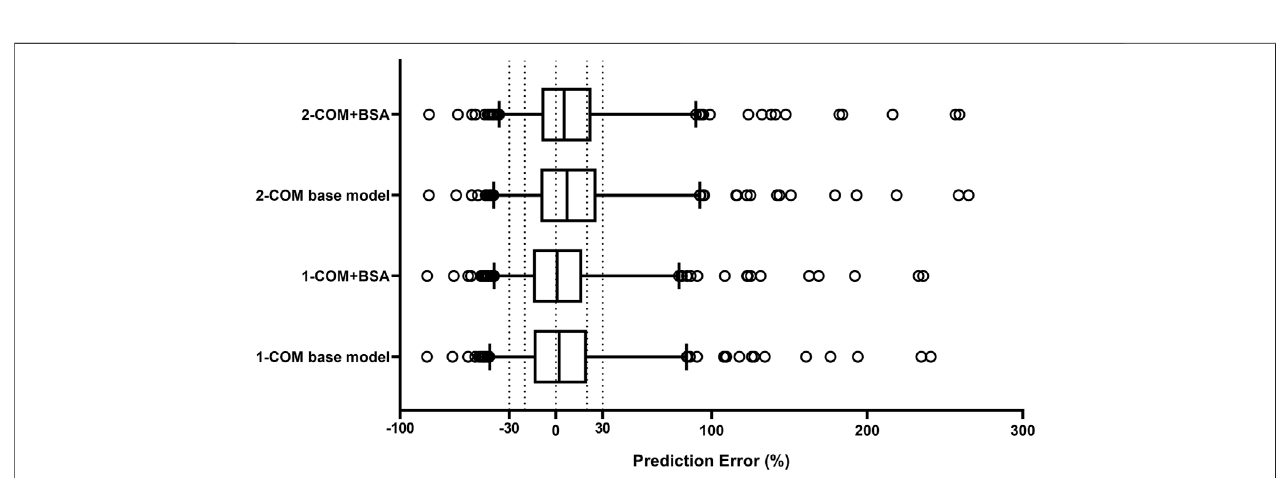
FIGURE 4 | Box plots of relative prediction error (PE%) for two structural models with or without covariates. Black solid line and dotted lines are reference lines indicating PE% of 0%, ±20% and ±30%, respectively. 1-COM, one compartmental model; 2-COM, two compartmental model; BSA, body surface area.